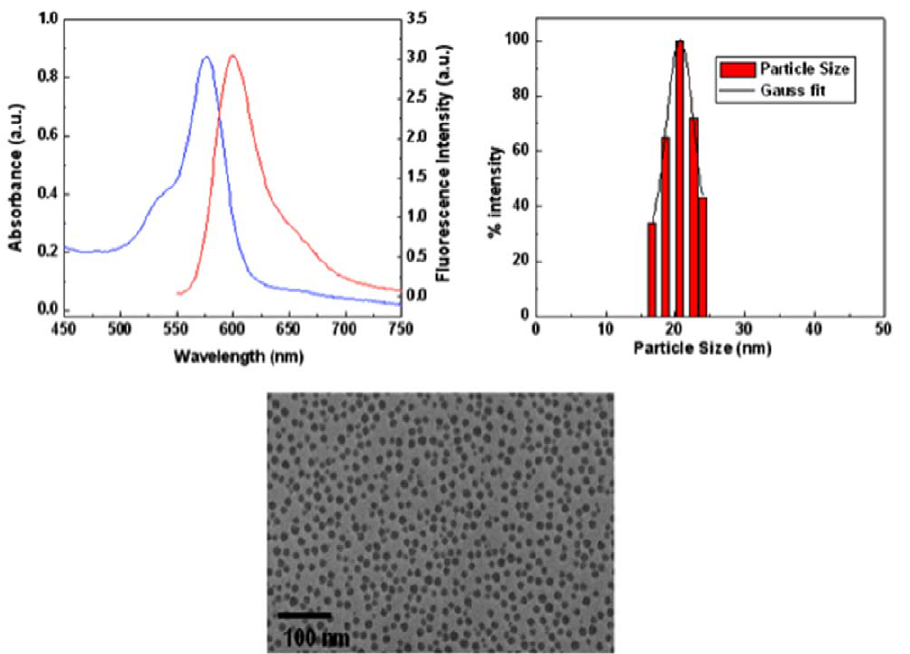
Figure 1. Physiochemical properties of ORMOSIL nanoparticles. ( A ) The absorption and emission spectra for rhodamine-ORMOSIL ( R ORM) particles. The typical emission band of rhodamine is l max 600 nm. ( B ) The ORMOSIL nanoparticle size distribution profile as measured by the dynamic light scattering (DLS) method indicates that the diameter of ORMOSIL nanoparticles are on average 20 nm. (C) A transmission electron microscope (TEM) image of ORMOSIL nanoparticles. Bar=100 nm.